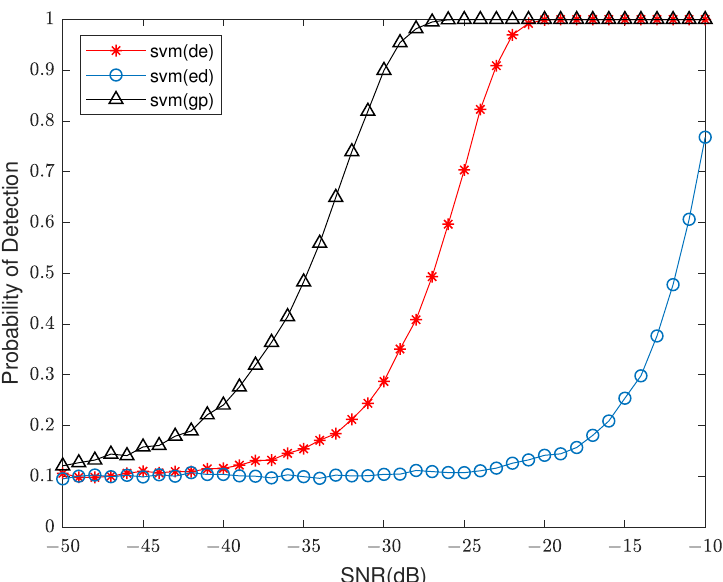
Figure 2. Performance comparison of SVM spectrum sensing methods based on GP, ES and DE. As can be seen from Figure 2, when the SNR is lower than − 25 dB, the detection probability of the SVM spectrum sensing method based on GP features is much higher than that of the SVM spectrum sensing method based on ES features and DE features, and the SVM spectrum sensing method based on GP features can achieve a detection rate close to 1 when the SNR is − 27 dB.